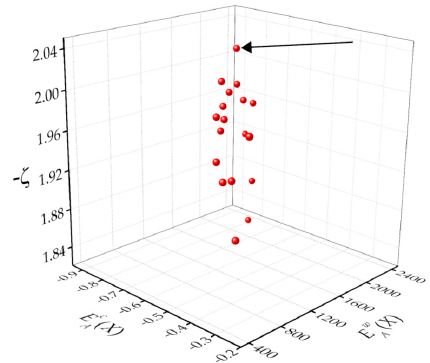
Figure 18. Pareto front.